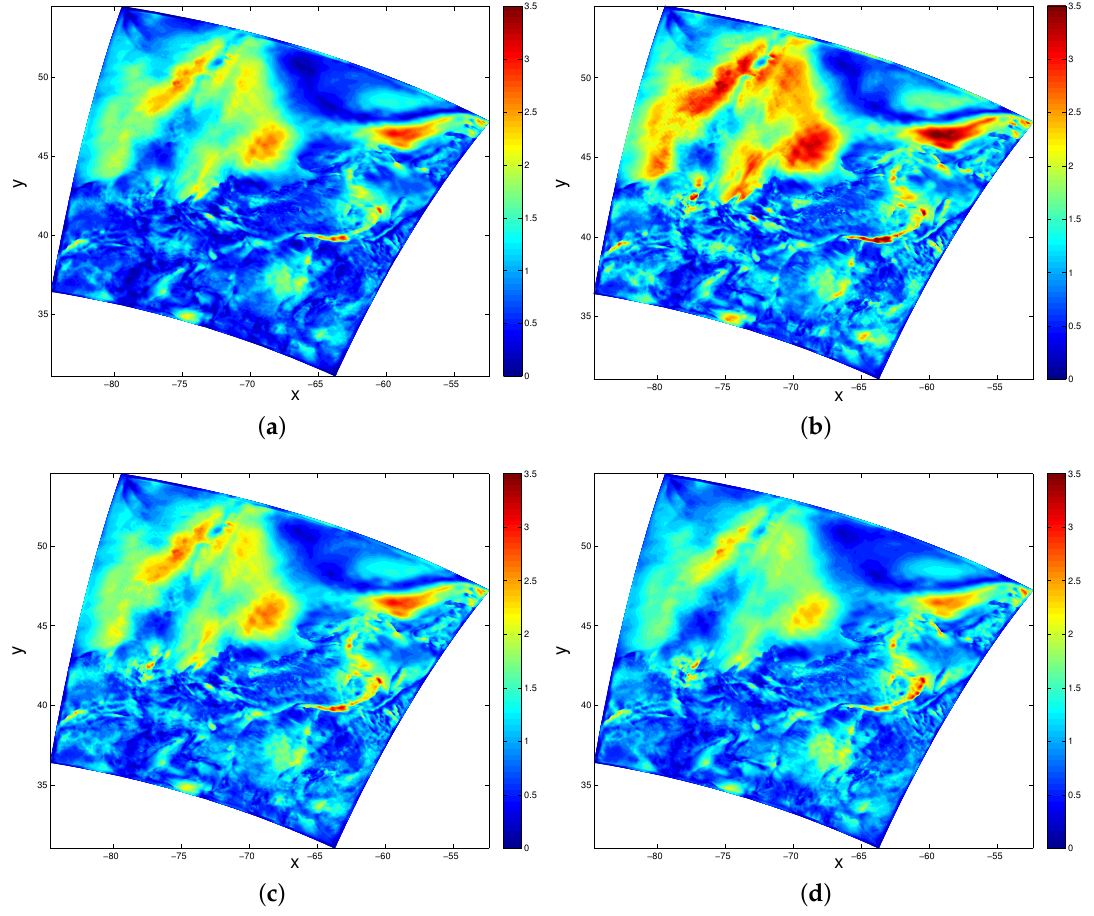
Figure 7. Standard deviation of the reconstructed snapshot 1 based on noisy measurement which depends on the wind field. ( a ) R = 0; ( b ) R = 0.5; ( c ) R = 1; ( d ) R = 2. ( x , t ) over all snapshots given σ Table 4. Average and maximum of σ U est R Value R = 0 R = 0.5 R = 1 R = 2 ( x , t maximum of σ U est